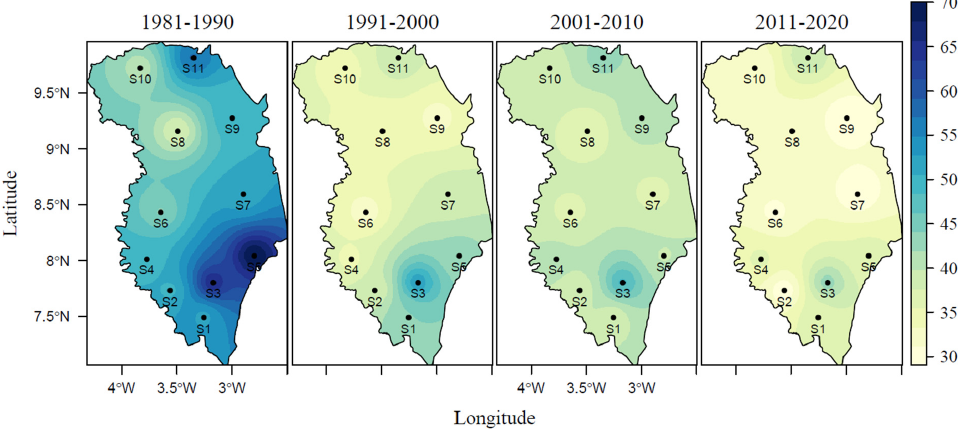
Figure 4. Spatial distribution of the consecutive wet days (CWD) (days) per decade in the Zanzan region. Stations (S1 = Koun Fao, S2 = Kouassi-datékro, S3 = Tanda, S4 = Sandegué, S5 = Bondoukou, S6 = Nassian, S7 = Sapli, S8 = PN Comoé S1, S9 = Bouna, S10 = Téhini, S11 = Doropo).